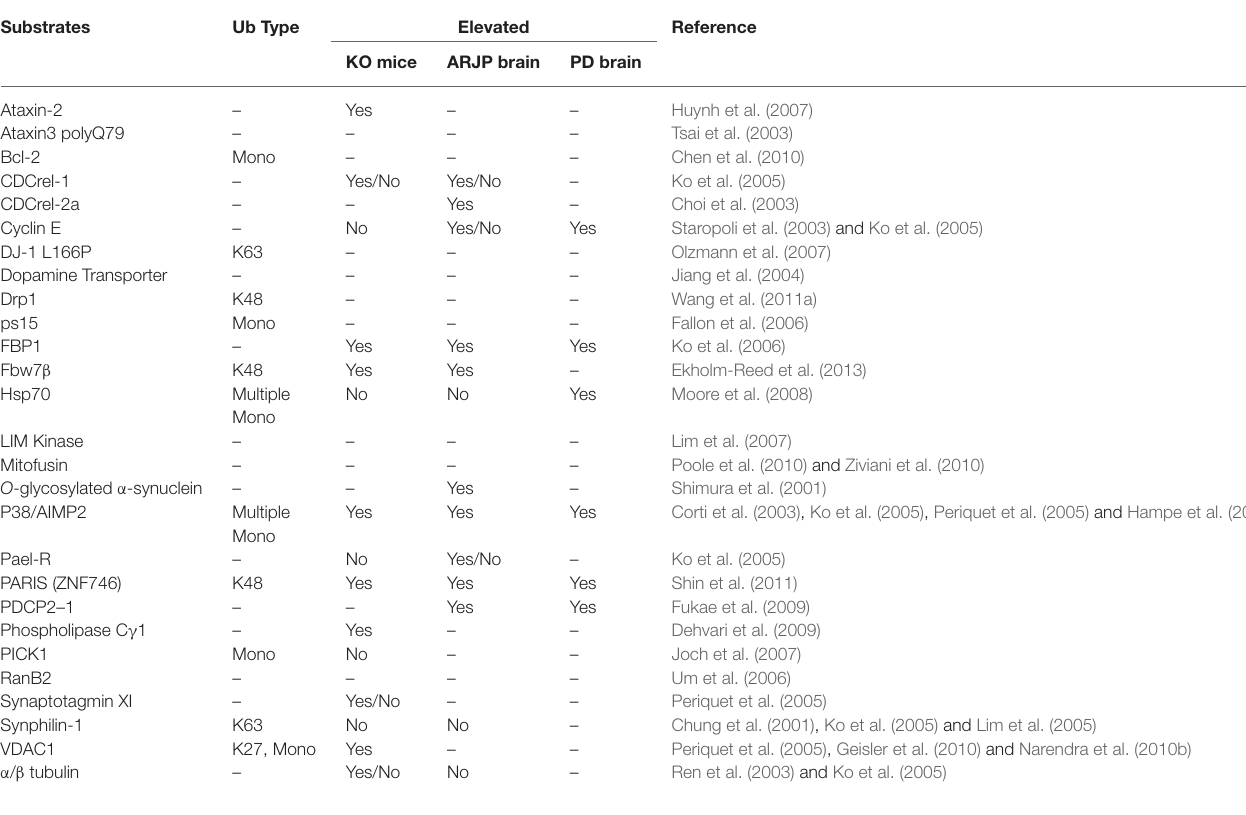
TABLE 1 | A selection of reported Parkin substrates .